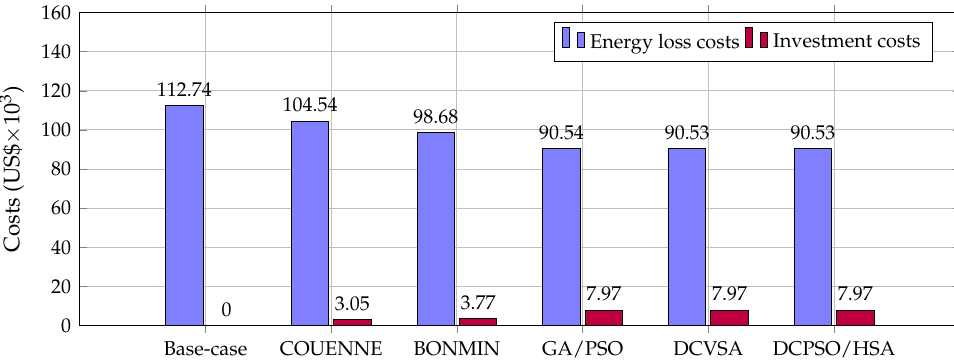
Figure 4. Comparison of operating and investment costs in the 33-bus system